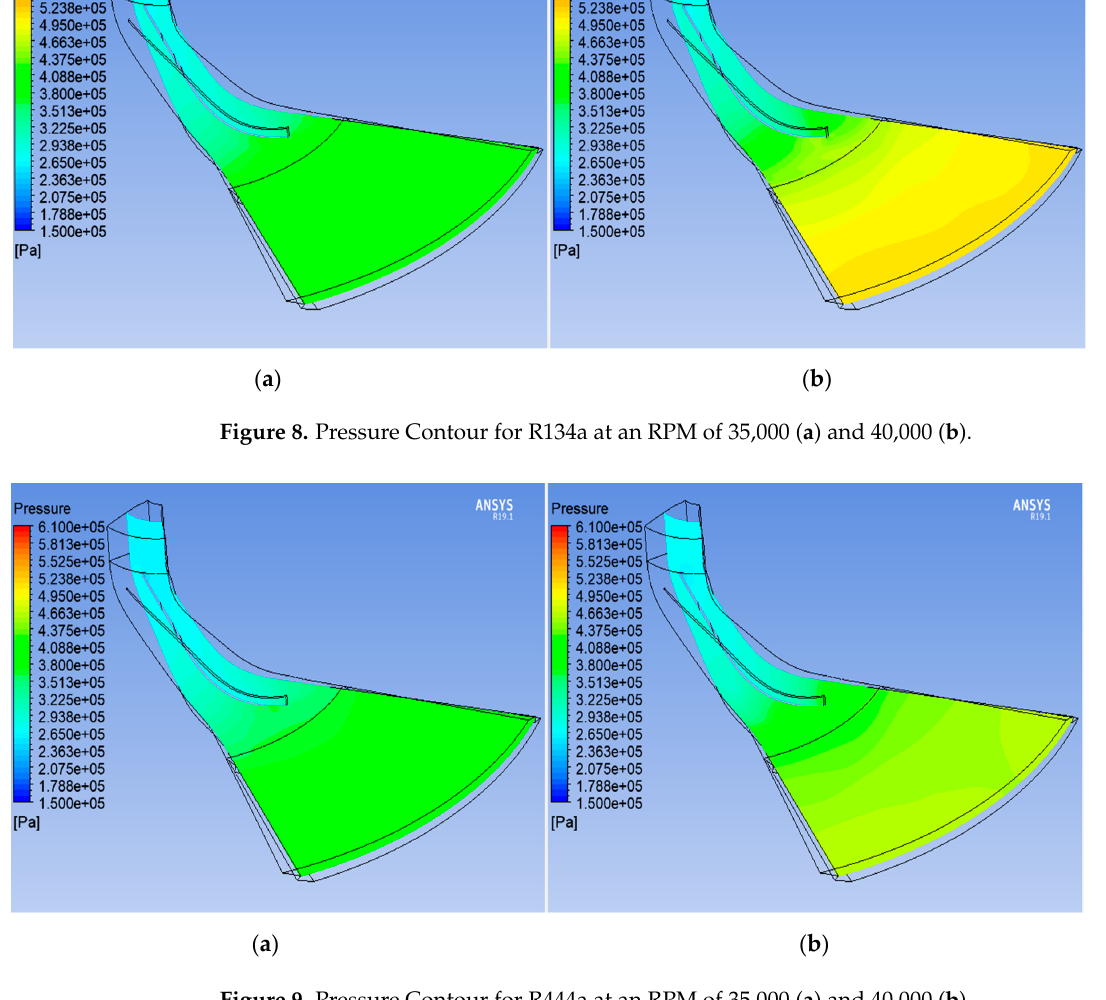
Figure 9. Pressure Contour for R444a at an RPM of 35,000 ( a ) and 40,000 ( b ).